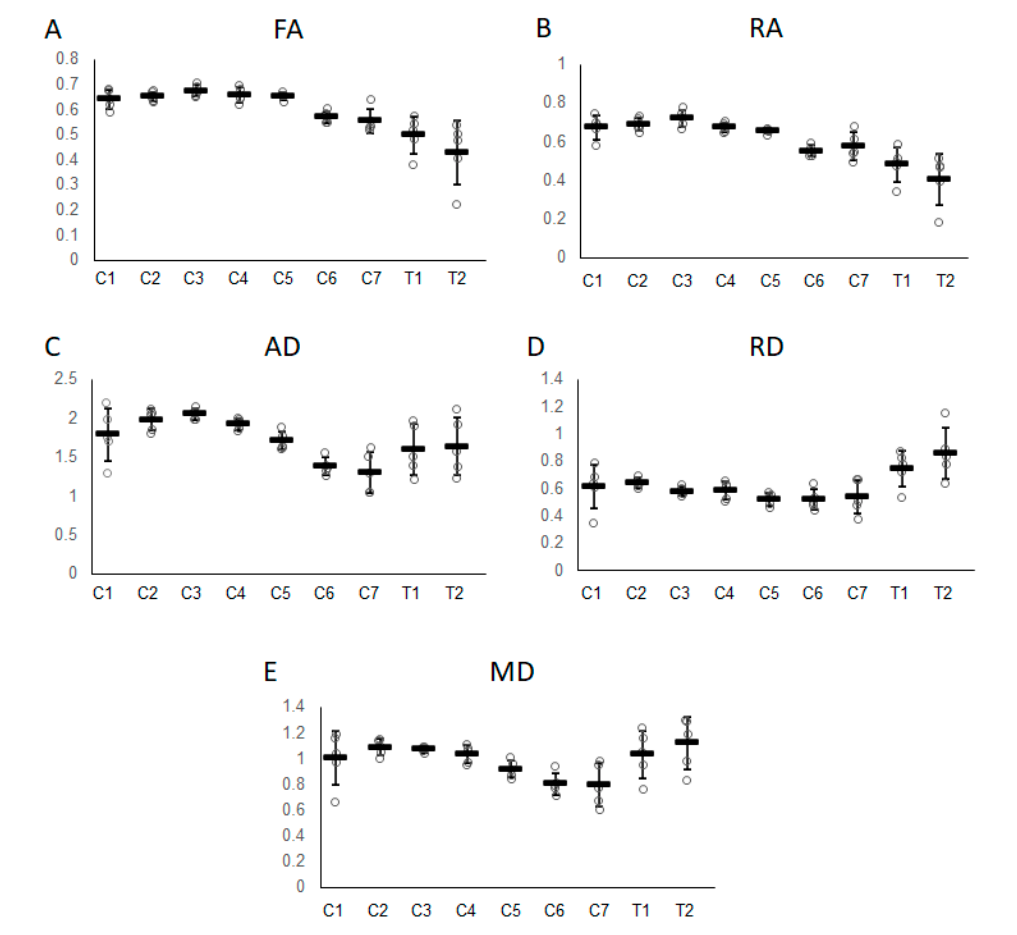
Figure 3. Graphs representing variations in ( A ) FA, ( B ) RA, ( C ) AD, ( D ) RD, and ( E ) MD values from the C1 to T2 vertebral levels. Error bars represent standard deviations.